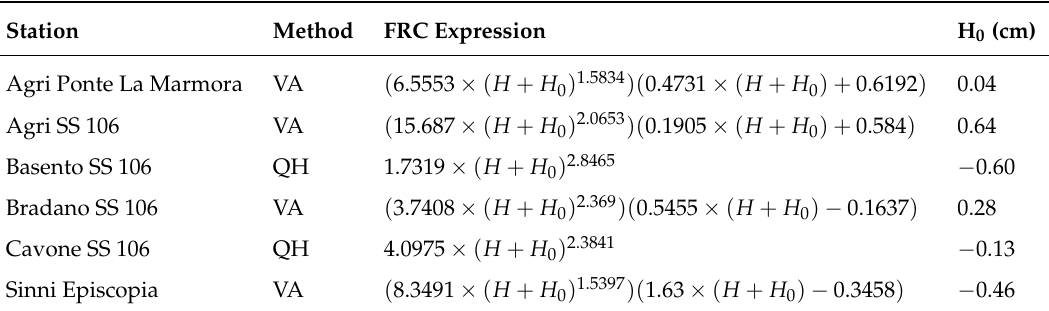
Table A1. Flow-rating curves chosen for each monitoring